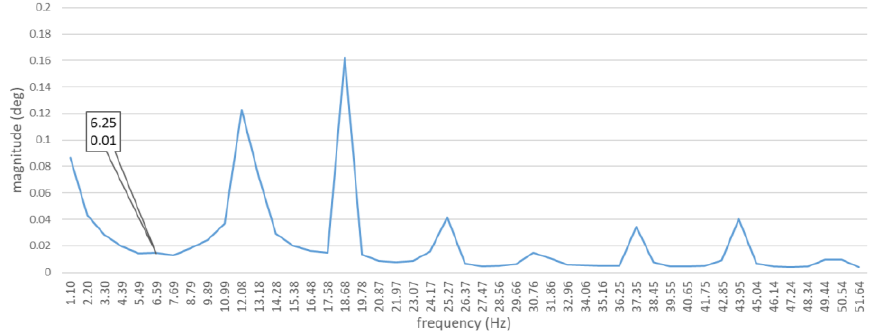
Figure 8. Mean value of torsional shaft vibration spectra. The diagram shows the 8th harmonic component only. Diesel–electric power unit with a defect-free ship engine.